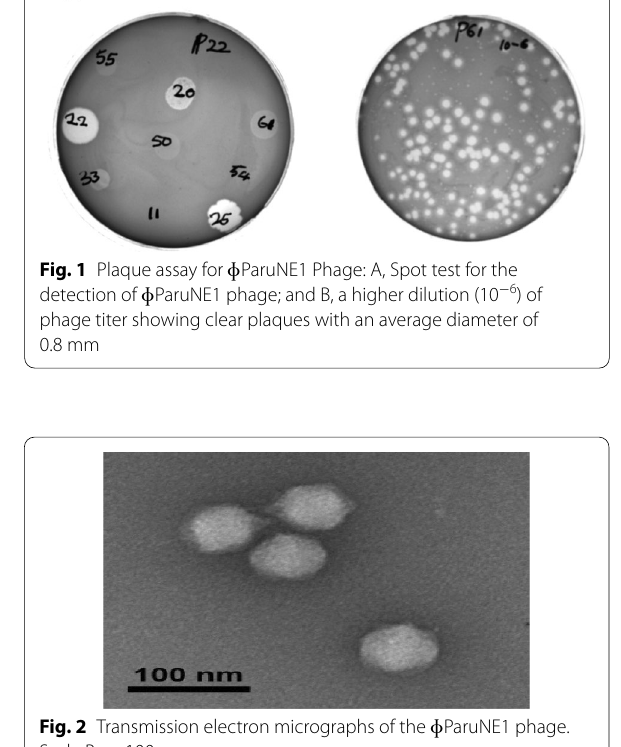
Fig. 2 Transmission electron micrographs of the ɸ ParuNE1 phage. Scale Bars, 100